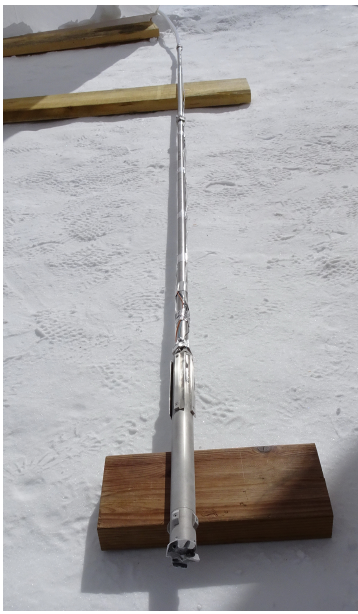
Figure 3. A 40mm firn drill on a vacuum line for lifting ice cut- tings. All pieces were manufactured in the workshop of the Physics Institute, University of